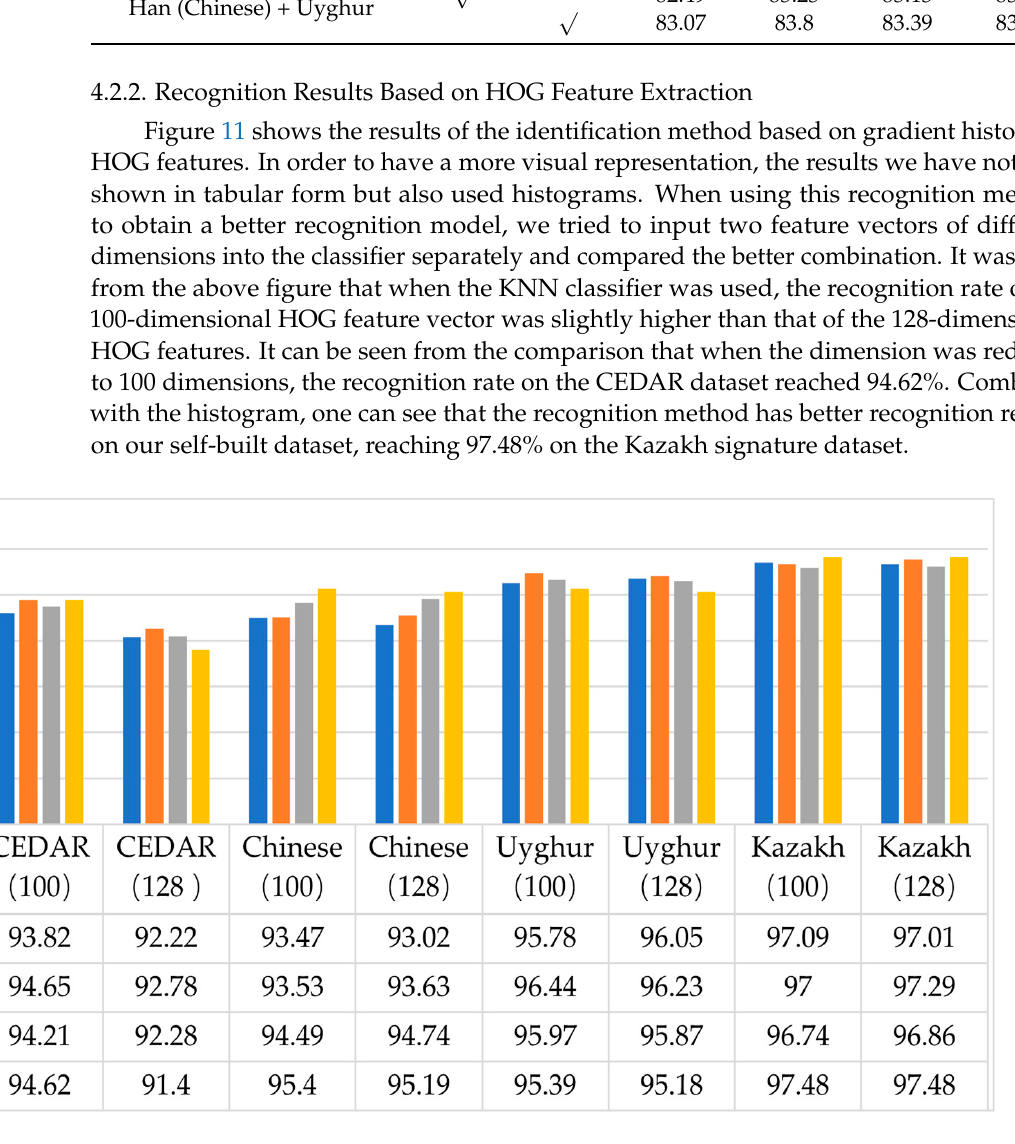
94.88 Table 4. Multilingual Mixed Signature Recognition Results Based on HOG Features. Dataset